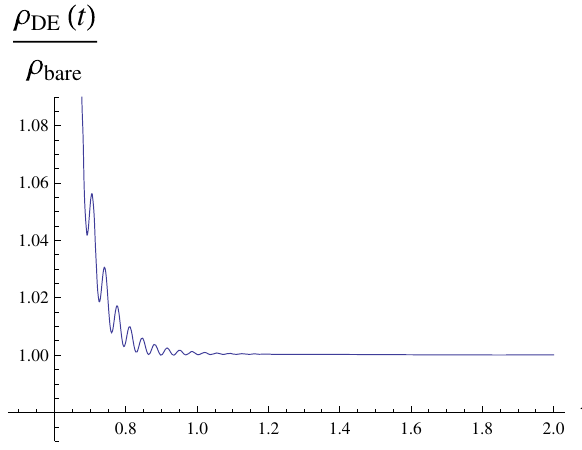
Fig. 1 The dependence ρ DE ( t ) [from Eq. (40)]. For illustration we put β = 800, Γ = 20 ¯ h and (cid:16) = 1000 ρ 0 bare . The qualitative behavior of ρ (cid:16) . The units of time t are determined by the DE does not depend on choice of units of Γ 0 because Γ 0 t ¯ is h